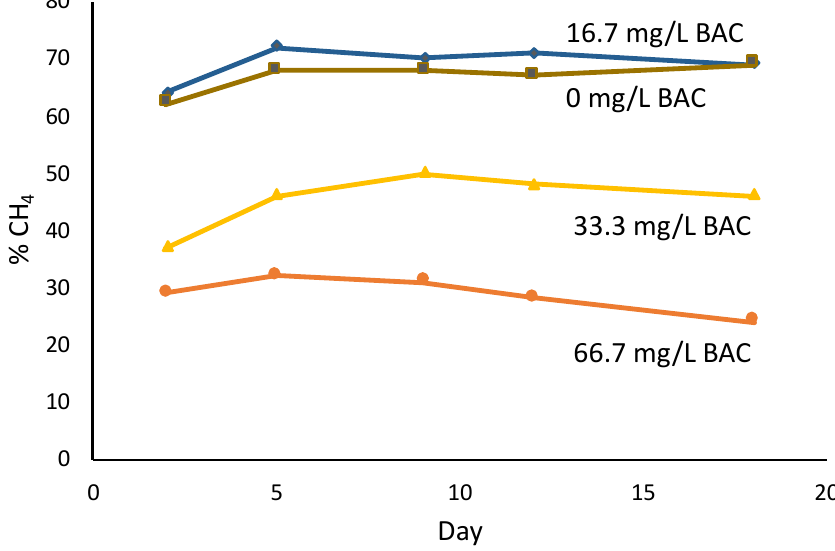
Figure 8. Percent of CH 4 in the microcosm headspace relative to the combined CH 4 and CO 2 after exposure to BAC.